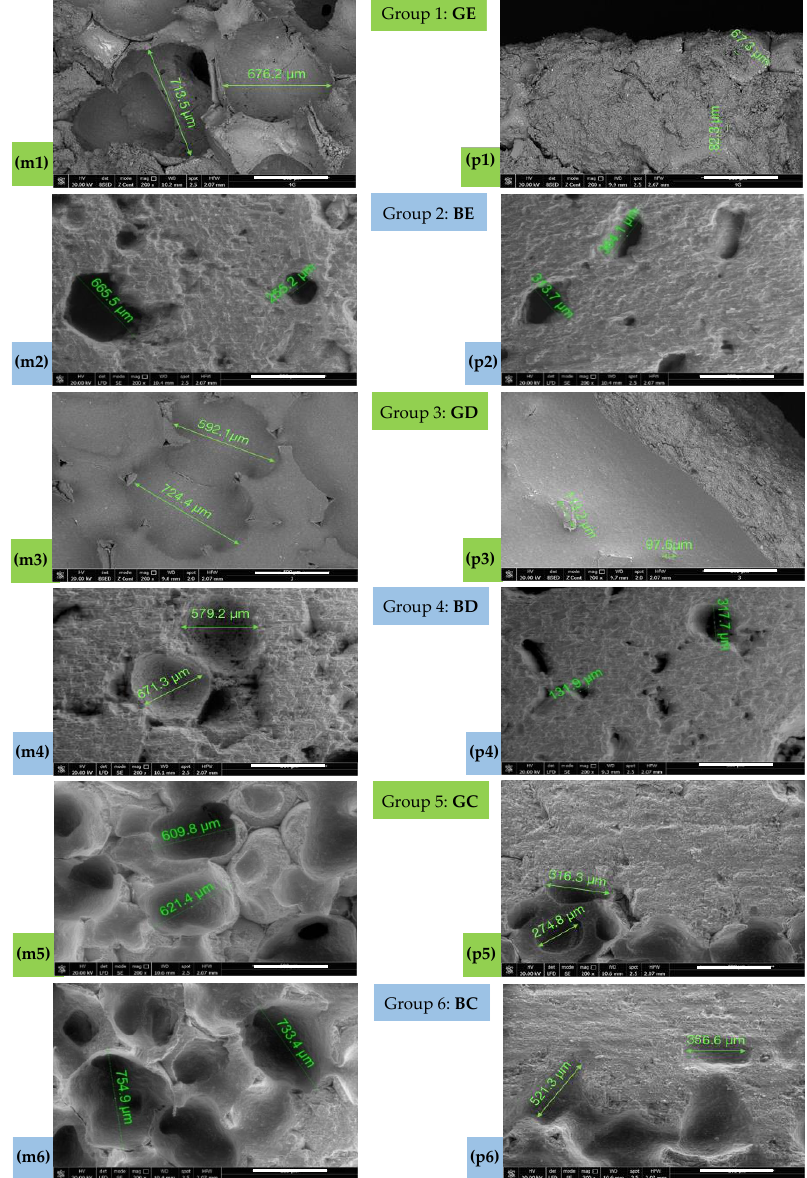
Figure 7. SEM images: ( m1 – m6 ) median/internal and ( p1 – p6 ) peripheral/outer/cortical position for Group 1 (GE), Group 2 (BE), Group 3 (GD), Group 4 (BD), Group 5 (GC), and Group 6 (BC) . Scale: 500 μm.